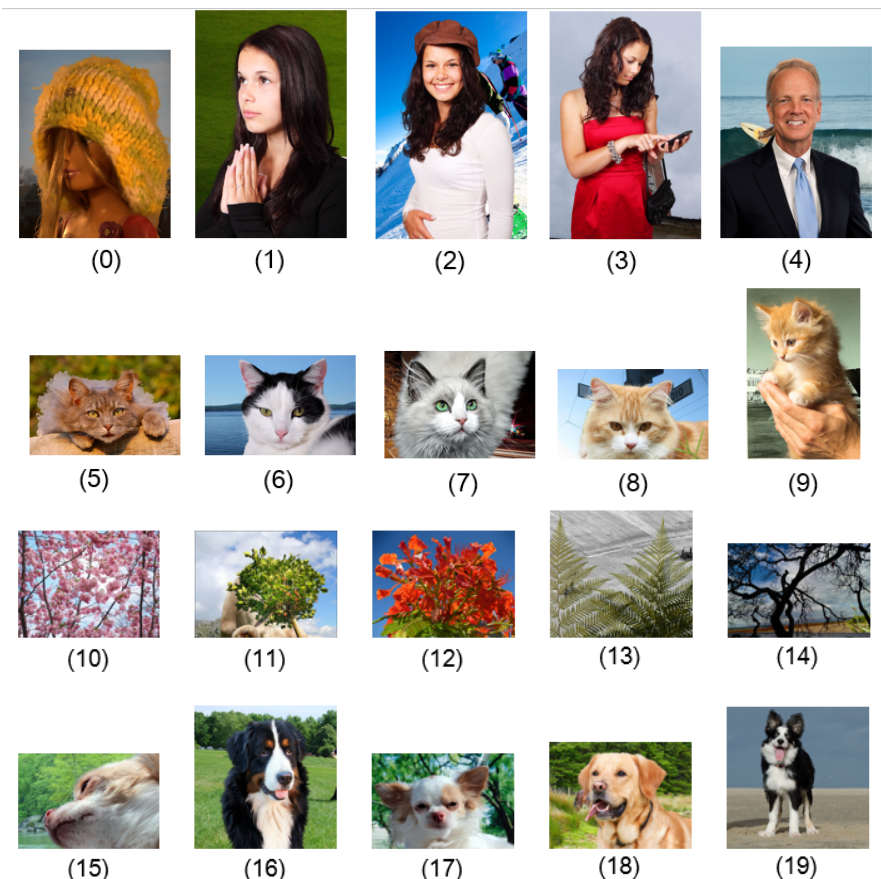
Figure 7. We select twenty images from [13]. Each row has the same category corresponding to Table 1, from top to bottom represents persons 0–4, cats 5–9, plants 10–14 and dogs 15–19, respectively. Subscripts represent image